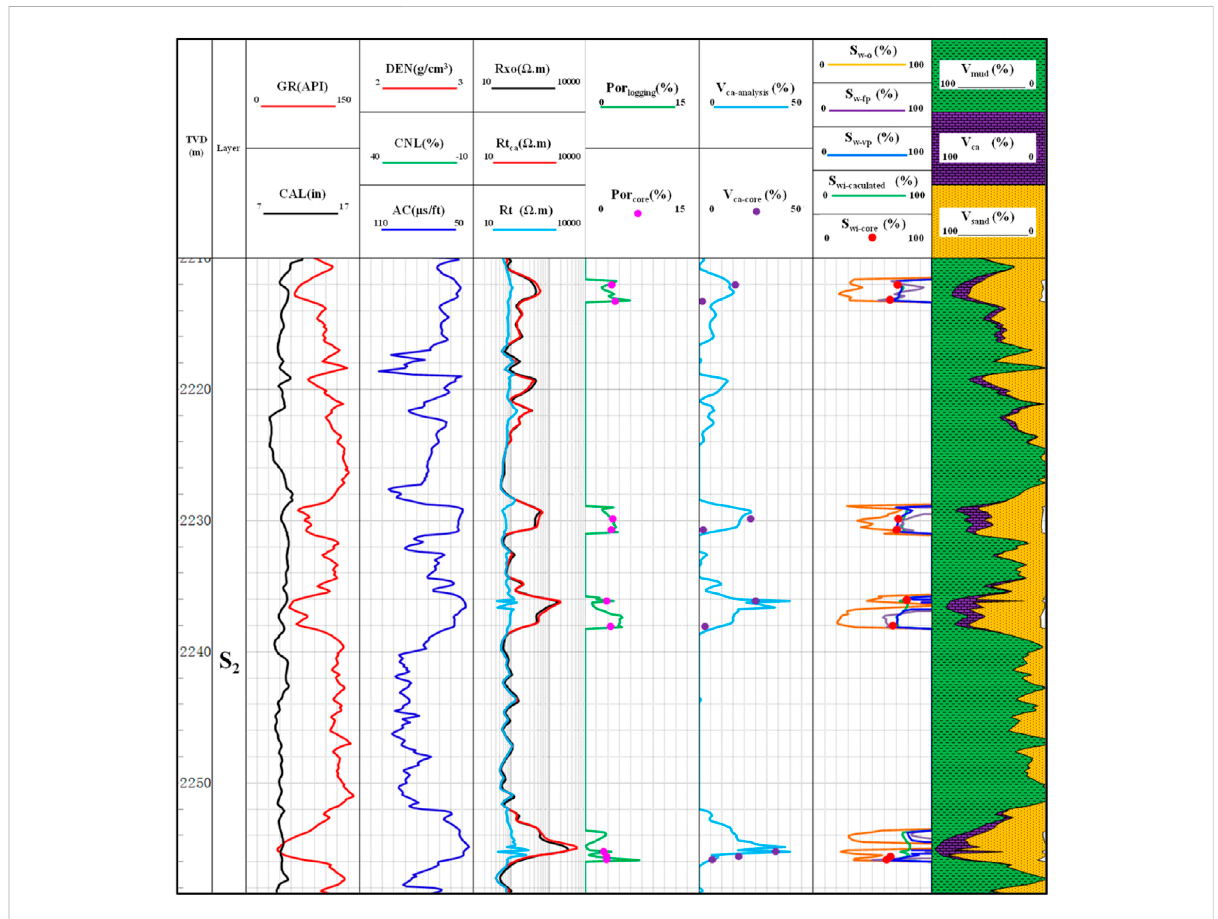
FIGURE 17 Comprehensive interpretation of Well